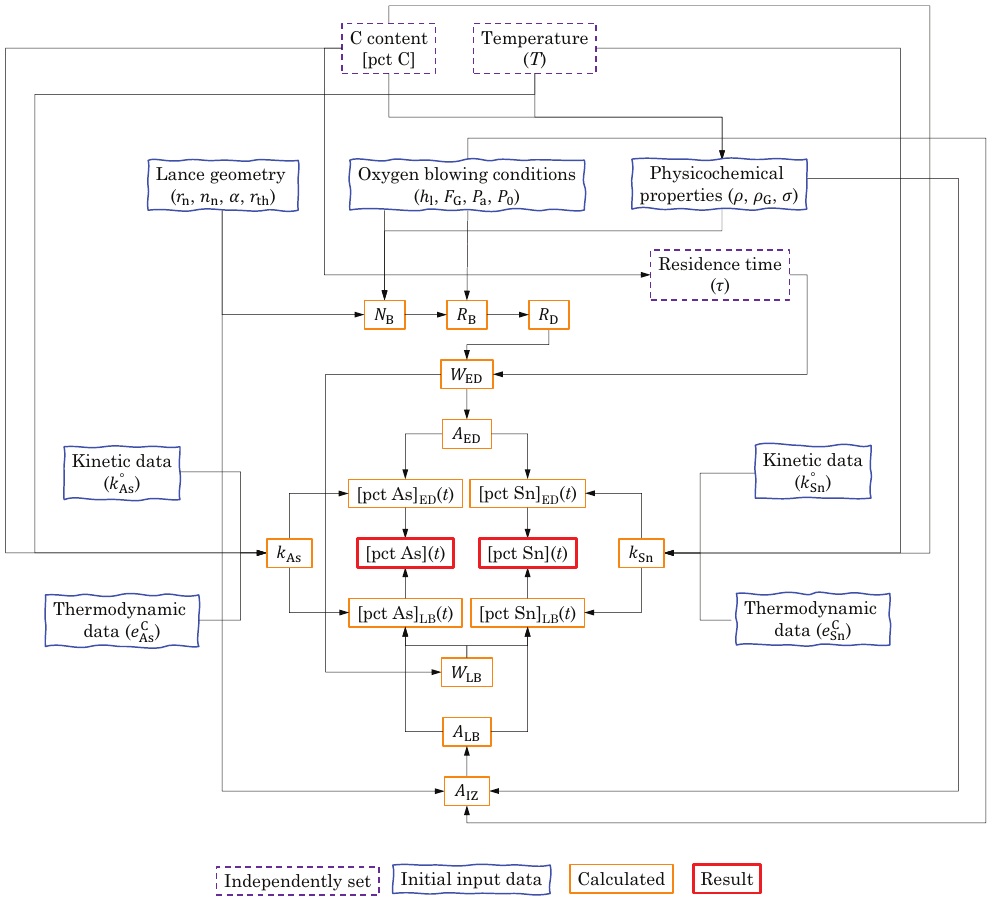
Figure 13. A flowchart of the steps of the present kinetic model calculation. (color online)